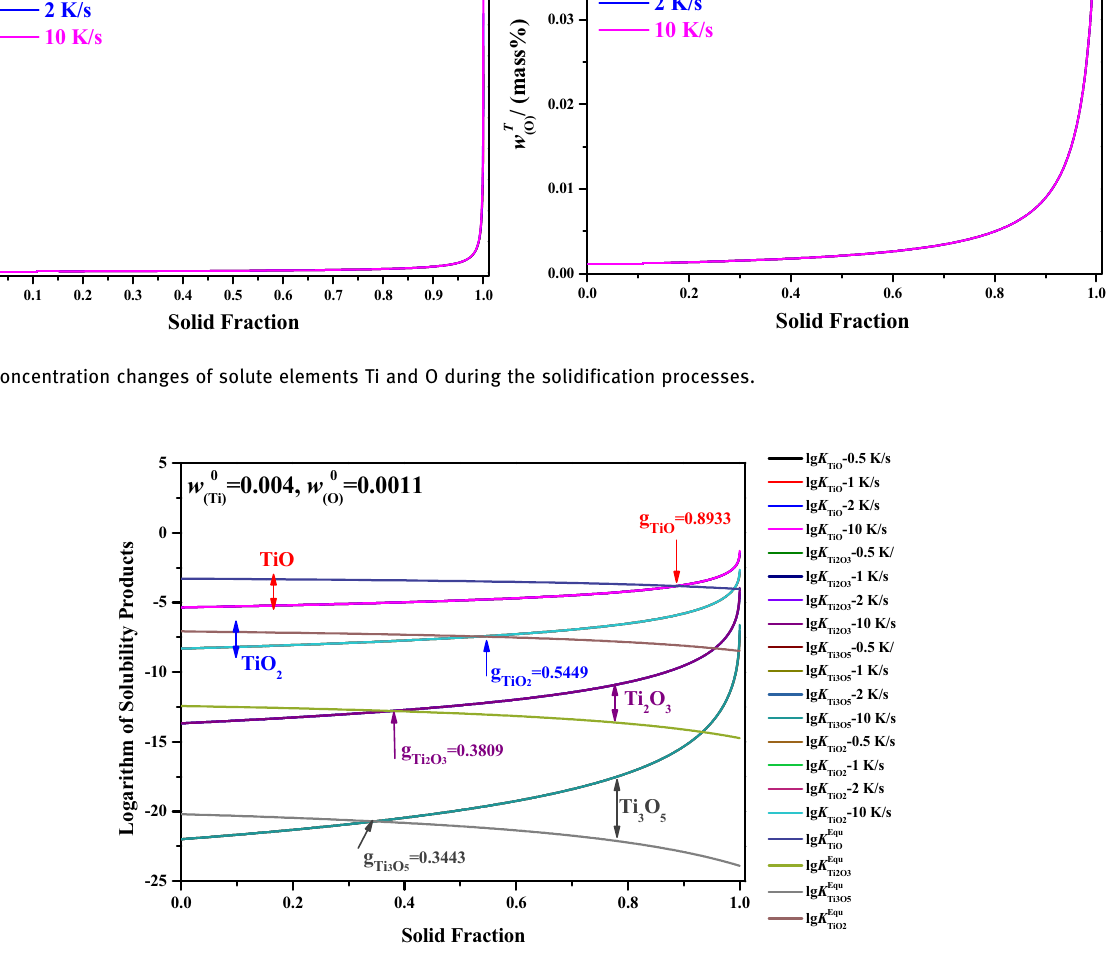
Figure 7: Comparisons of the equilibrium solubility products and the actual values of Ti – O compounds at different cooling